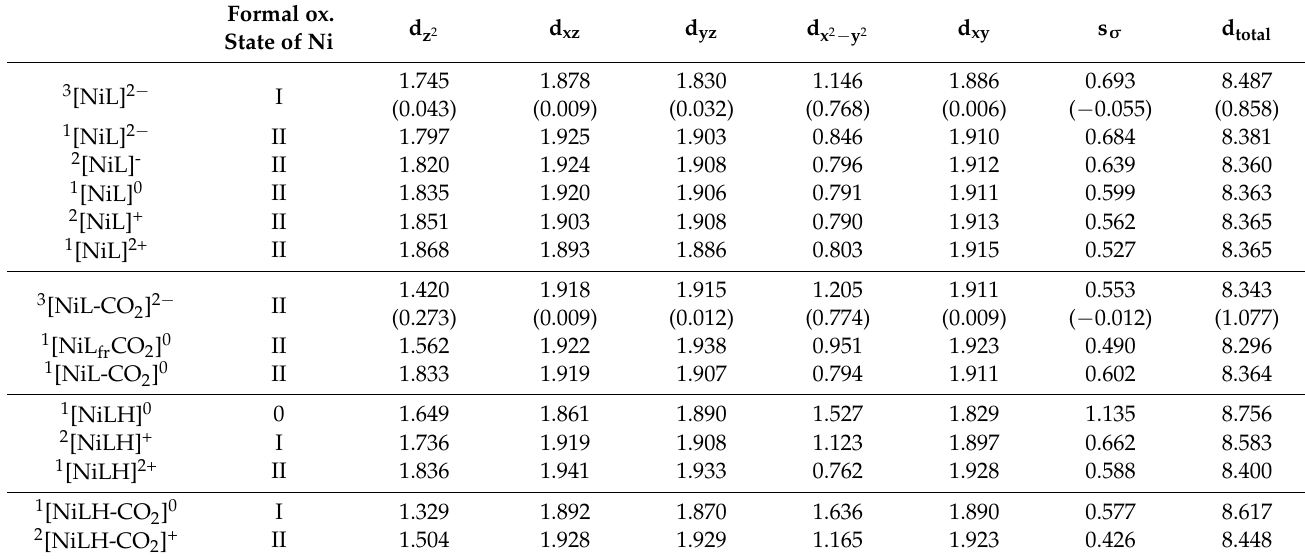
Table 3. B3LYP/6-311G* formal oxidation state of Ni and Mulliken d-orbital populations on the central atoms of the studied complexes (spin population for chosen triplet state complexes in